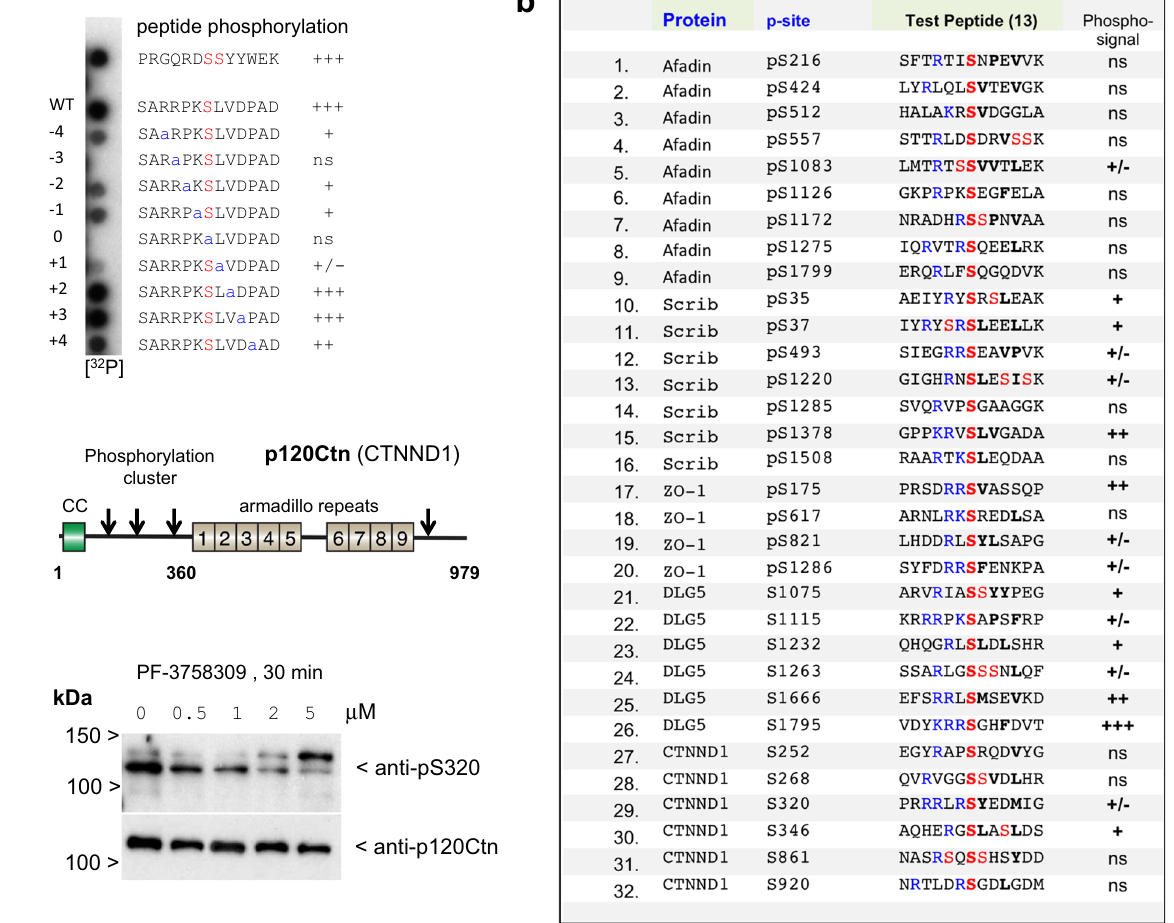
Fig. 7 Peptide spot analysis of putative target sites in PAK4-proximal proteins. a To assess the effect of single amino-acid substitution on a selected optimal PAK4 substrate, we tested 13aa synthetic peptides (Pepspots, Jerini) derived from PAK4 pseudosubstrate motif (SARRPKPLVDPAD) in which the proline in bold is replaced by Ser(0). This is similar to an optimal substrate for PAKs (RKRRNSLAYKK) termed PAKtide 145 but optimal for kinase binding. Based on structural considerations the Arg side chain at position − 2 or − 3 occupies a pocket that mediates interactions found in PAKs and other S/T kinases, including PKA 146 . The contribution of each side-chain to peptide phosphorylation was assessed by sequential alanine substitution. b We selected in vivo basic-directed phosphorylation sites identi fi ed in Afadin, scribble, ZO-1, DLG5 and p120ctn as compiled in the Phosphosite database (V6.5.9.3). The corresponding synthetic peptides were synthesized and subjected to in situ phosphorylation. The extent of phosphorylation (32P signal) ranges from detectable ( − / + ) to very strong ( +++ ), with no signal shown as ns. c Schematic of the domain structure and relative positions of the p120-catenin phosphorylation sites as indicated in the table. d Western blot showing the inhibition of p120ctn Ser320 phosphorylation by PF-3758309 U2OS cells 113